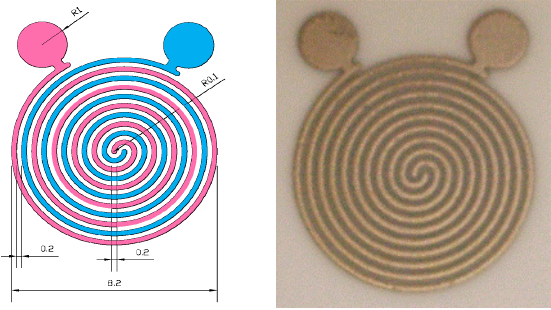
Figure 1. The structure is circular electrode (size: 1 cm × 1 cm).